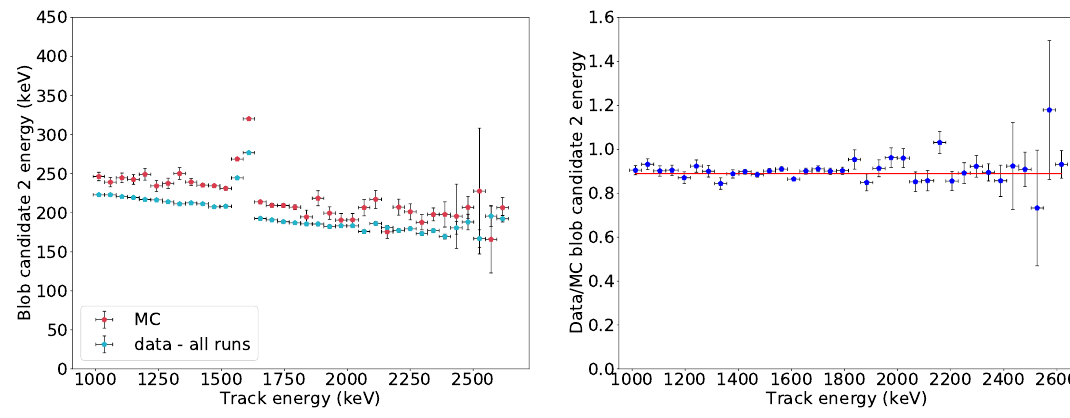
Figure 5 . Energy of blob candidate 2 as a function of the track energy for data and Monte Carlo. The left panel shows the average value for each bin, while the right panel shows the ratio between data and Monte Carlo and a linear (cid:12)t to the distribution.